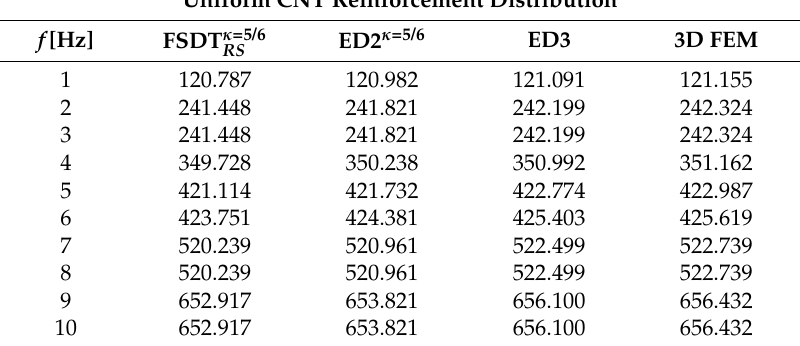
Table 2. Comparison between the first ten natural frequency variations of a CCCC square plate made of a single CNT-reinforced lamina of constant thickness h = 0.1m given by GDQ method and FEM. The 3D FEM solution was obtained by commercial software Strand7.